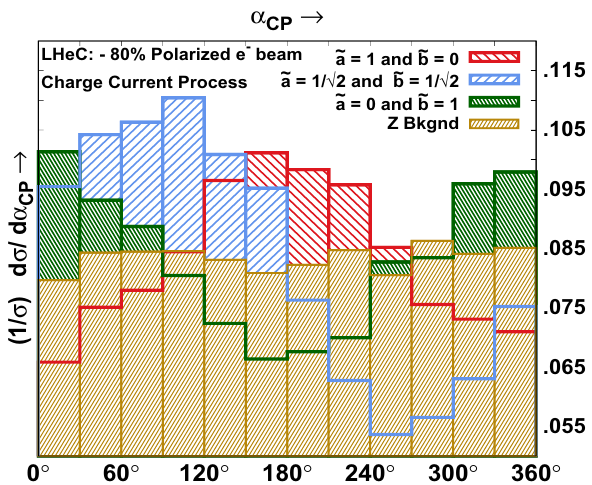
Fig. 3 Normalized differential cross-sections w.r.t. CP sensitive observable α CP for the process e − p → ( h → τ + τ − )ν e jets; and τ − ( + ) → ν τ ( ¯ ν τ ) + ρ − ( + ) → ν τ ( ¯ ν τ ) + π − ( + ) + π 0 corresponding to SM pure CP -even (in red), 50% mixed (in blue) and pure CP - odd (in green) states respectively. The contribution from dominant Z background channel is shown in golden yellow. These distributions are simulated for LHeC set up with − 80% polarised 150 GeV electron and unpolarised 7 TeV proton